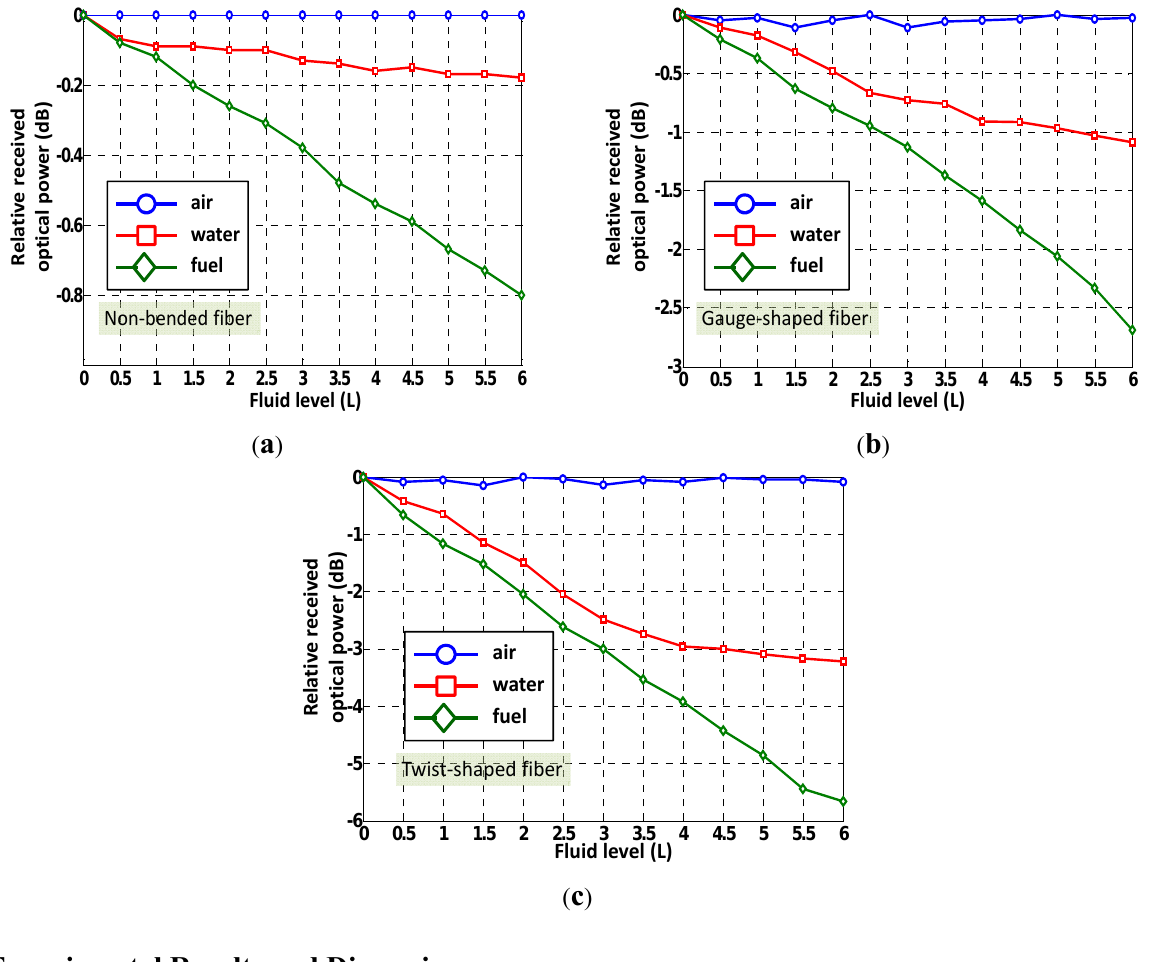
Figure 3. Relative optical power detected for different fluids and sensing probes as a function of the level of fluid. ( a ) Non-bended fiber sensing prototype; ( b ) Gauge-shaped fiber sensing prototype; ( c ) Twist-shaped fiber sensing